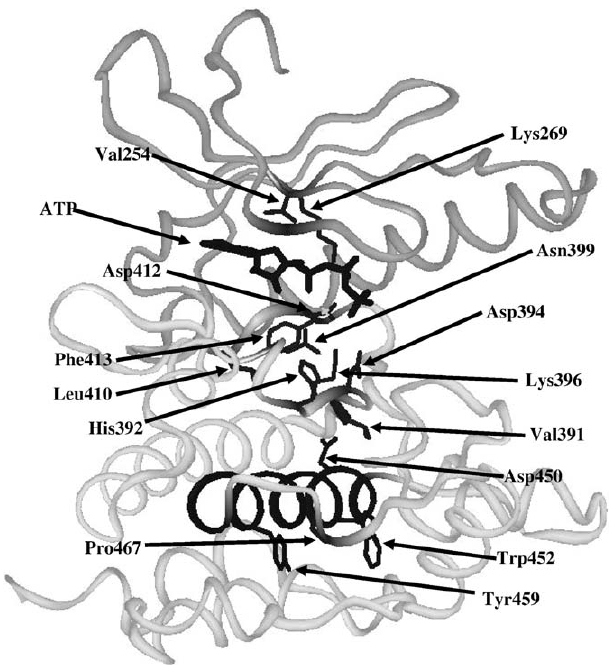
Figure 2. Structural Conservation and Protein-Kinase Fold in ROP18 and Related Proteins The side chains of residues strictly conserved among PDB1PHK and various ROP2s (ROP17, 18, 2L3, and 2L4) are shown in black and wire- frame on the backbone of PDB1PHK. The hydrophobic segment (corresponding here to residues 443 to 463 in ROP18) is in black colour and appears buried into the all-alpha domain. The ATP molecule is shown in black and thick wire-frame in order to localise the active site in which conservation corresponds mainly to catalytic residues. Residue numbering refers to the ROP18